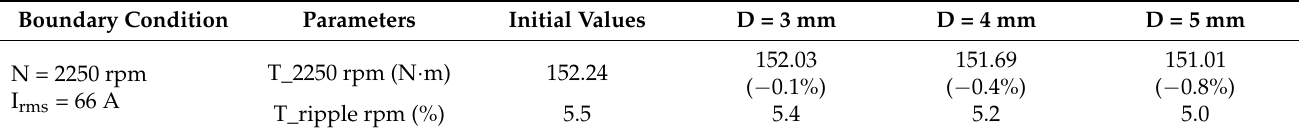
Table 8. Optimization design results of rotor rivet hole